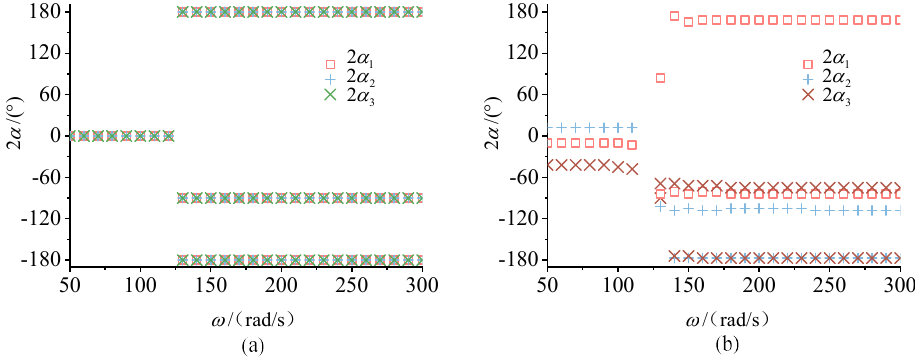
Figure 2. Stable phase differences: ( a ) Identical motor parameters; ( b ) Different motor damping.